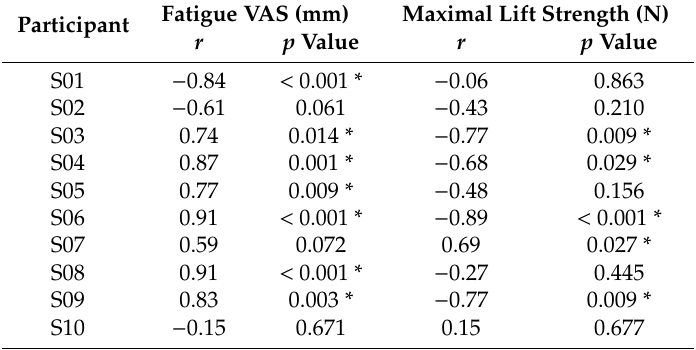
Table 2. The subject-specific Pearson’s correlation coe ffi cients ( r ) between the spine motion composite index (SMCI) and fatigue visual analogue scale (VAS), and between the SMCI and maximal lift strength. The degrees of freedom (DF) = 8 for all